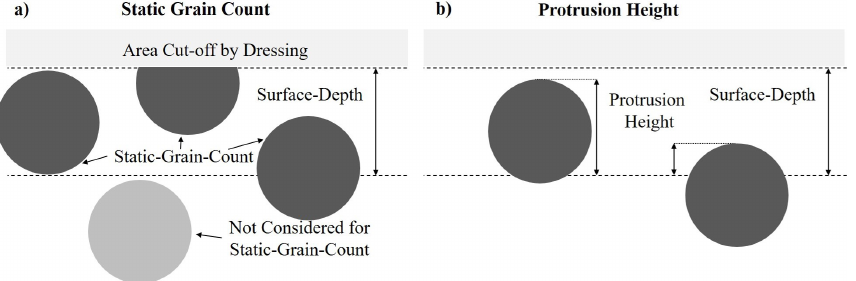
Figure 12. Visualisation of ( a ) static grain count and ( b ) protrusion height; partly adapted from